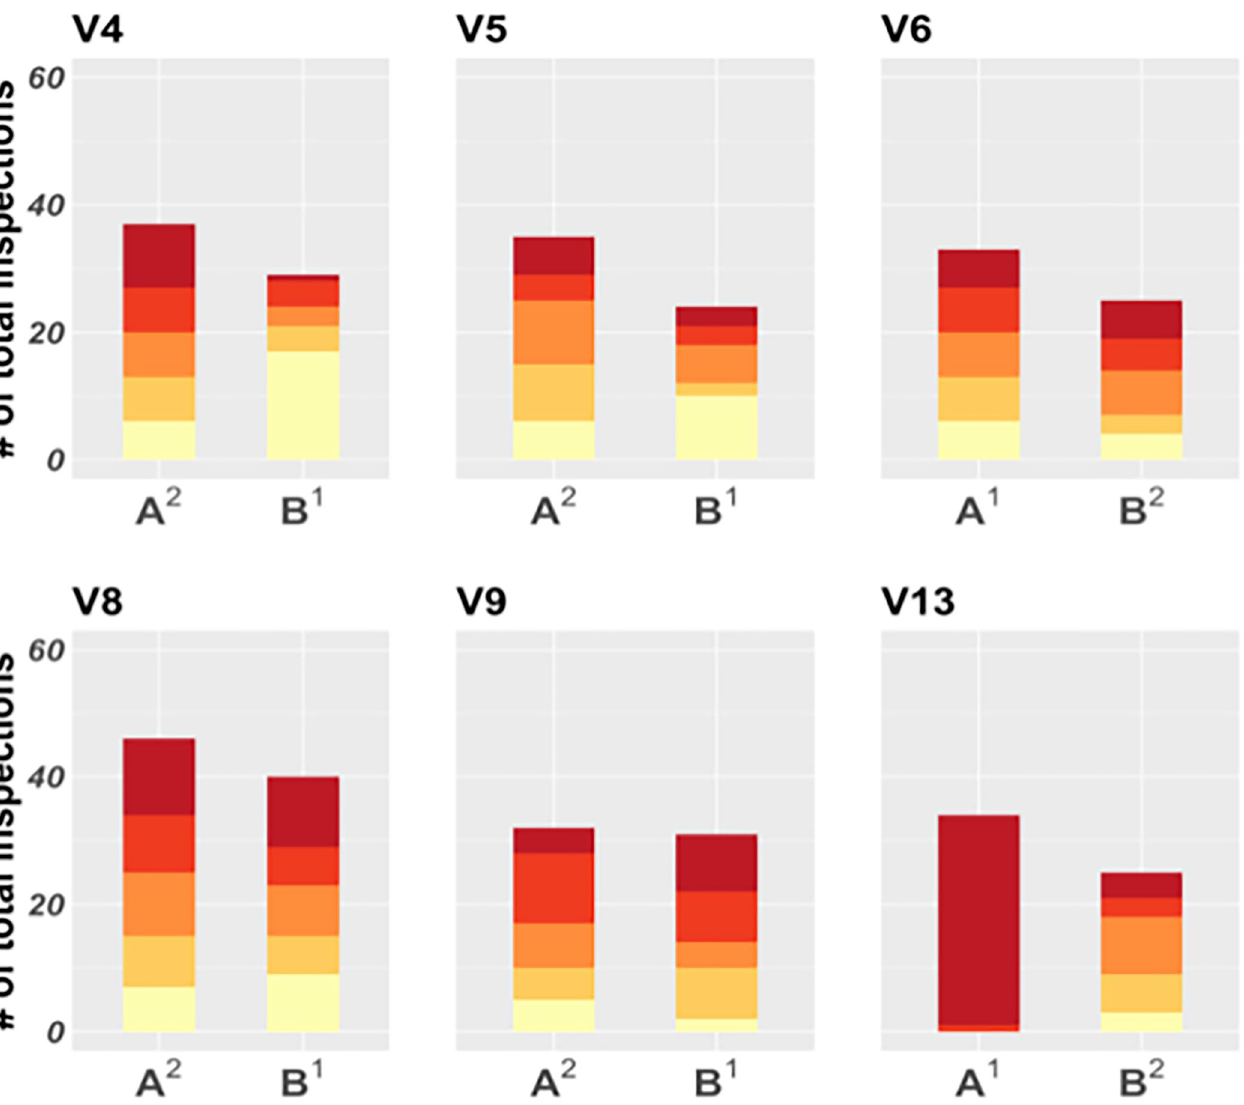
Fig 7. Distribution of household infestation risk quintile of households inspected by participants in the Jose Luis Bustamante y Rivero (JLByR) Trial. Each set of two bars represents one participant, and each bar, a study arm (A or B). Colors are ordered by risk quintile, going from the lowest (light yellow, bottom) to the highest (dark red, top). In arm A, the secret houses and spatial coverage incentives were used, while arm B employed only the pay-per-detection incentive. Superscripts 1 and 2 in the x axis text indicate arm